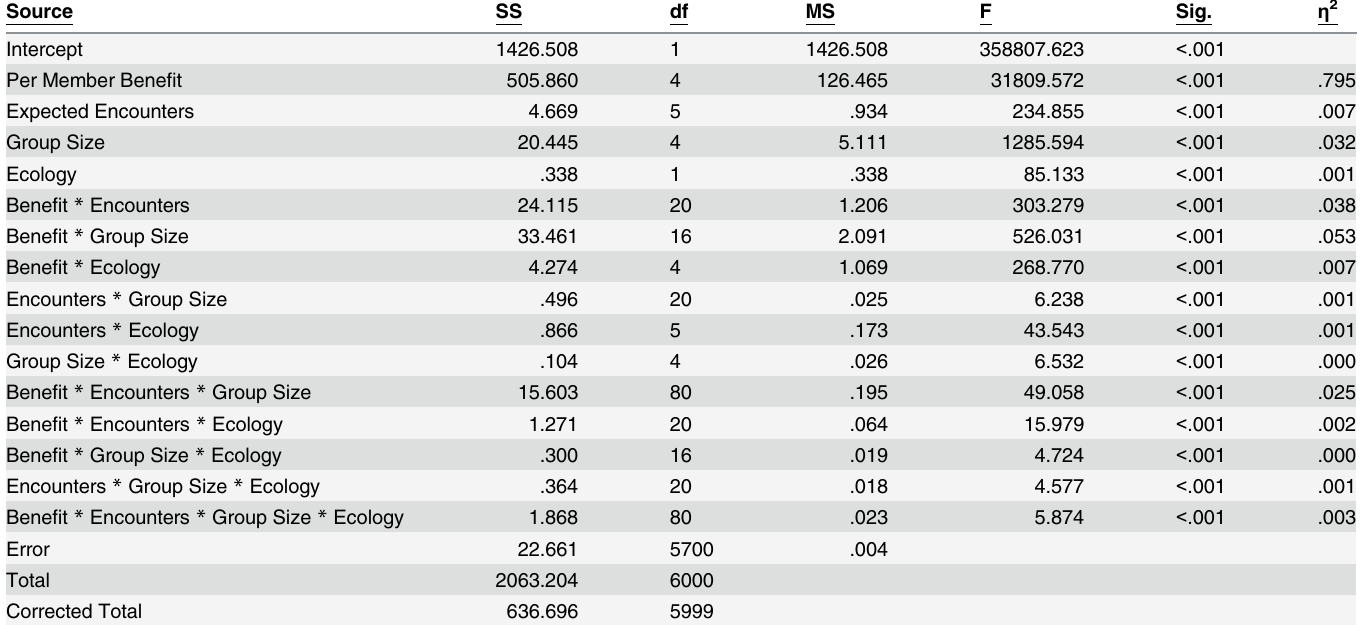
Table 2. GLM of Default-Cooperation Probability